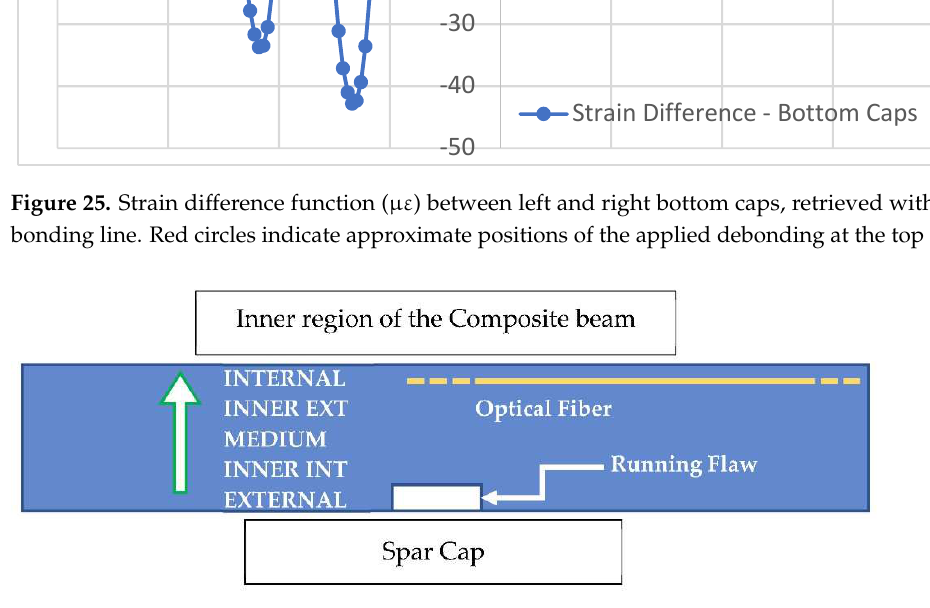
Figure 26. Schematic representation of the imposed disbonding, and the codification of the N.5 subsequent positions along the cap. View from above; internal section of the composite beam deployed on the top of the picture. This schematic is the reference for the data shown in all the other pictures (Figures 27–31).